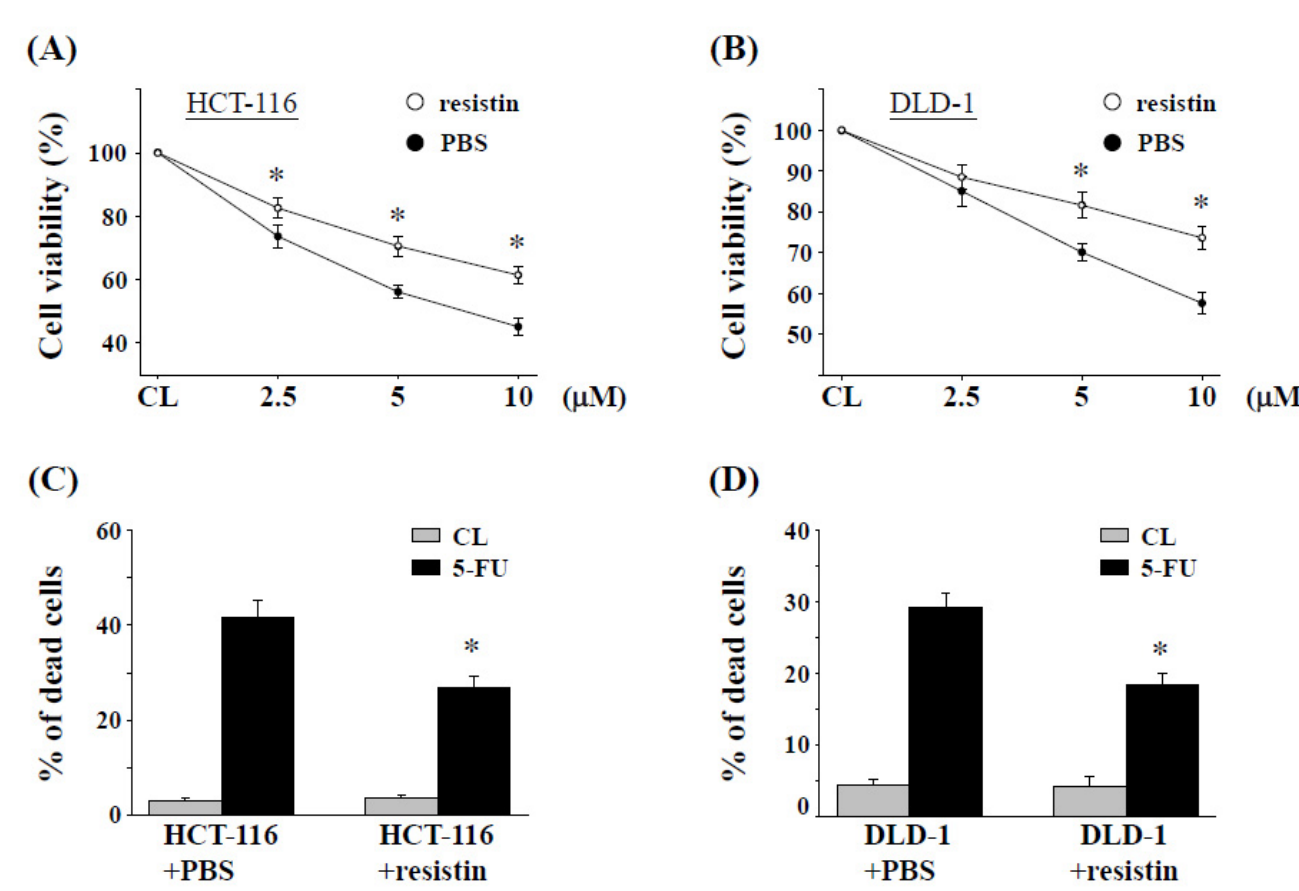
Figure 2. Resistin promotes 5-FU resistance in CRC cells. ( A ) HCT-116 cells and ( B ) DLD-1 cells pretreated with resistin (50 ng/mL) for 12 h were further treated with the indicated doses of 5-FU (0–10 µ M) for 48 h in the presence of resistin, and cell viability was determined by MTS assay. Cells treated with PBS served as the control. The OD value of control cells was taken as 100% viable. ( C ) HCT-116 cells and ( D ) DLD-1 cells pretreated with 50 ng/mL resistin for 12 h were further treated with 5 µ M 5-FU for 48 h in the presence of resistin, then both unattached and attached cells were collected and stained with trypan blue dye, and the number of dead cells was manually counted. The percentage of trypan blue-positive cells represented the population of dead cells. Data represent the mean ± SEM from three independent experiments; * p < 0.05.